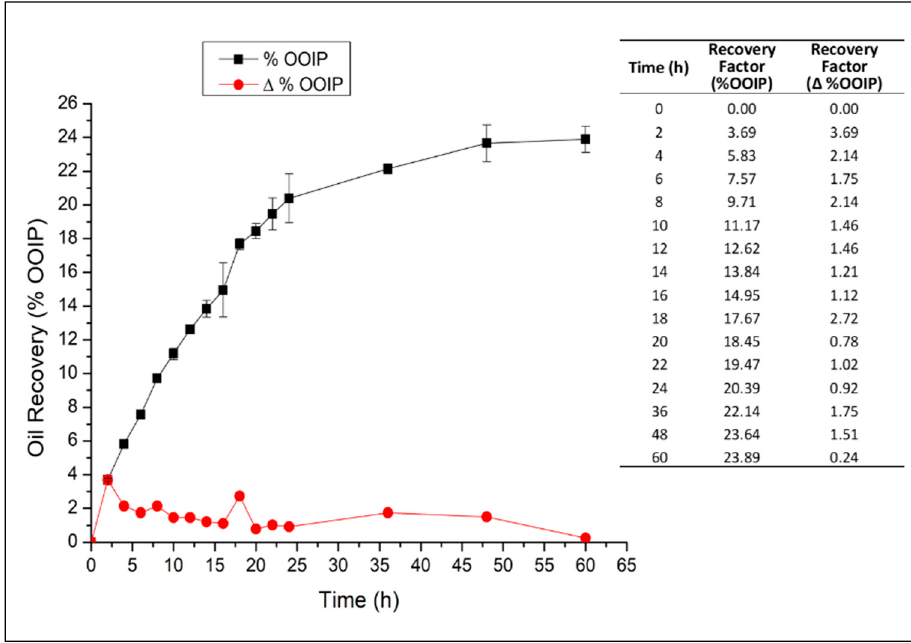
Figure 9. Residual oil recovery by applying the biosurfactant solution from H. meridiana BK-AB4.